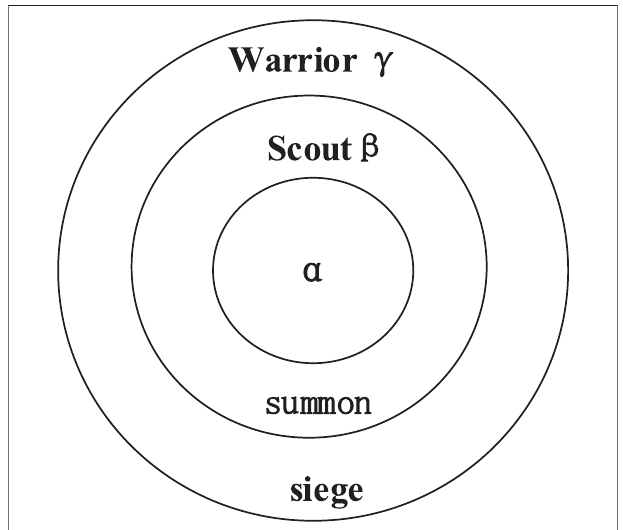
FIGURE 1 | Wolves social class and behavioral relationship.